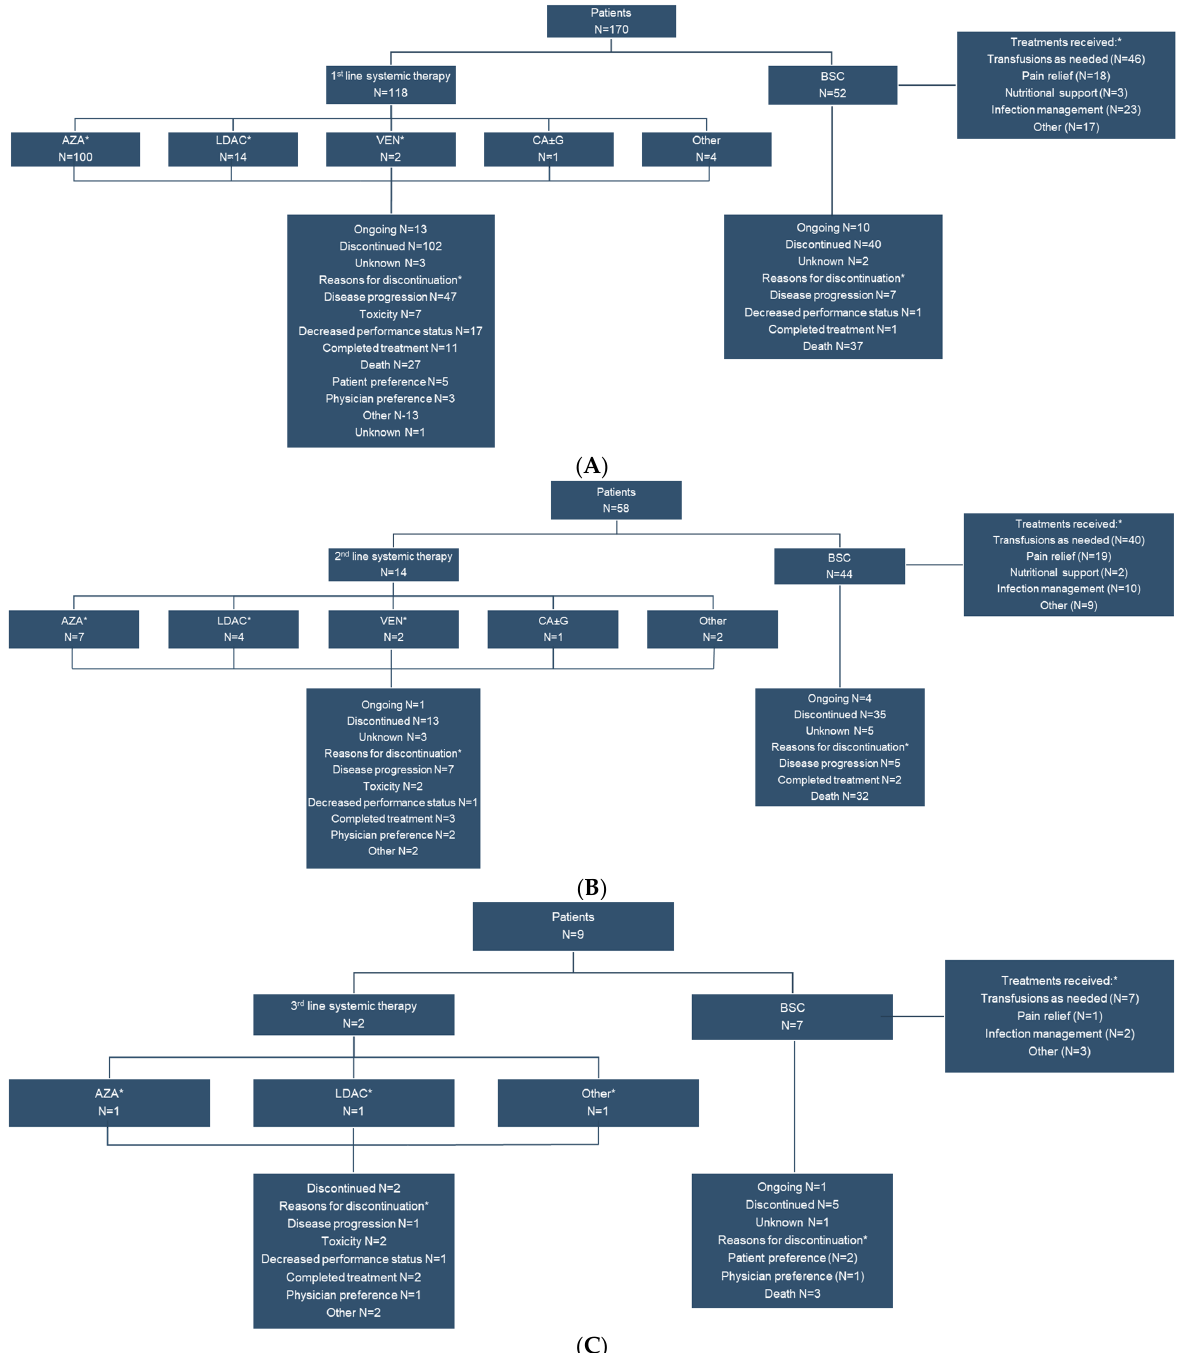
Figure 1. First line ( A ), second line ( B ) and third line ( C ) treatment patterns and disposition of Canadian patients ineligible for high intensity chemotherapy. * Patients may be taking more than one systemic therapy simultaneously. AZA, 5-azacitidine; BSC, best supportive care; CA ± G, cytarabine, aclarubicin, G-CSF regimen; G-CSF, Granulocyte—colony stimulating factor; LDAC, low-dose cytarabine; VEN, venetoclax.